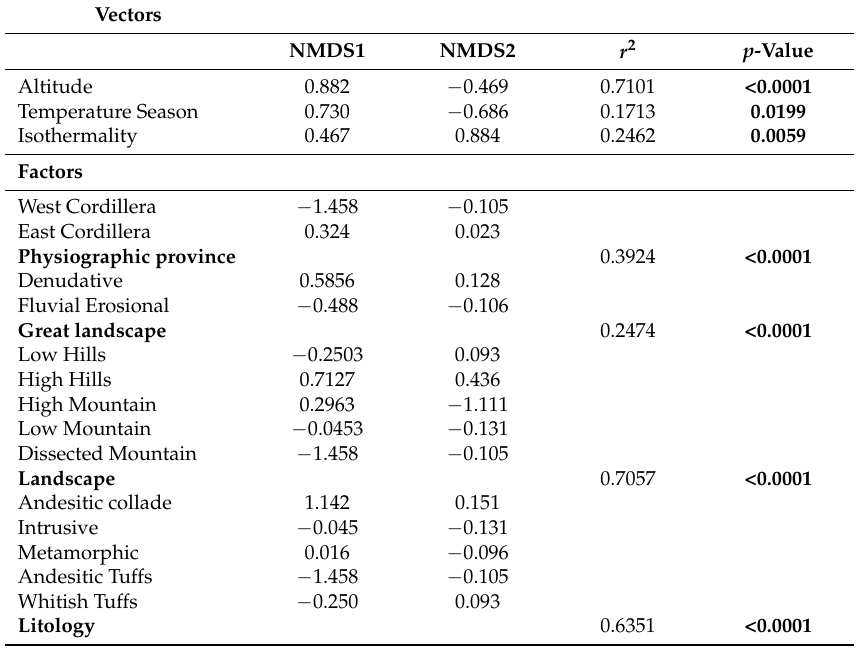
Table 4. Significant variables affecting the grouping of montane forest in Southern